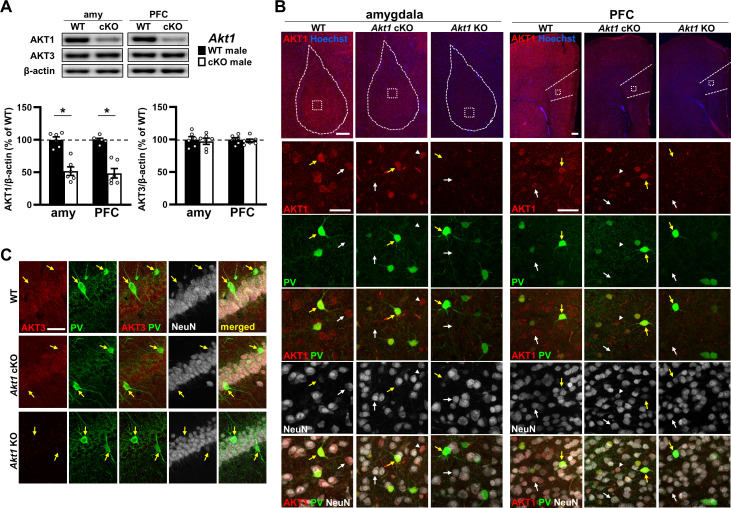
AKT1 expression in conditional Akt1 KO (Akt1 cKO) male mice under the excitatory neuron-specific T29-1 Camk2α-Cre driver.(A) Western blot analysis shows reduced AKT1 levels in the amygdala (amy) and prefrontal cortex (PFC) of Akt1 cKO mice compared with WT controls while AKT3 levels are not affected. β-actin, loading control. N = 6/genotype. *p<0.05. (B) Immunostaining shows AKT1 is normally expressed in both excitatory and inhibitory neurons, marked by NeuN, and confirms AKT1 removal in Akt1 cKO mice from most neurons, putatively excitatory neurons (white arrows), in the amy and PFC. Inhibitory neurons marked by parvalbumin (PV, yellow arrows) show intact AKT1 expression in Akt1 cKO mice. Arrowhead, putative inhibitory neuron of another subtype (PV-negative). Hoechst, nuclear stain. Scale bars: 200 μm (top row), 40 μm (below). (C) AKT3 is normally detected in excitatory neurons but not PV-positive neurons (yellow arrows) in hippocampal area CA1 and does not show a compensatory increase in expression in Akt1 cKO mice. Scale bar, 40 μm.